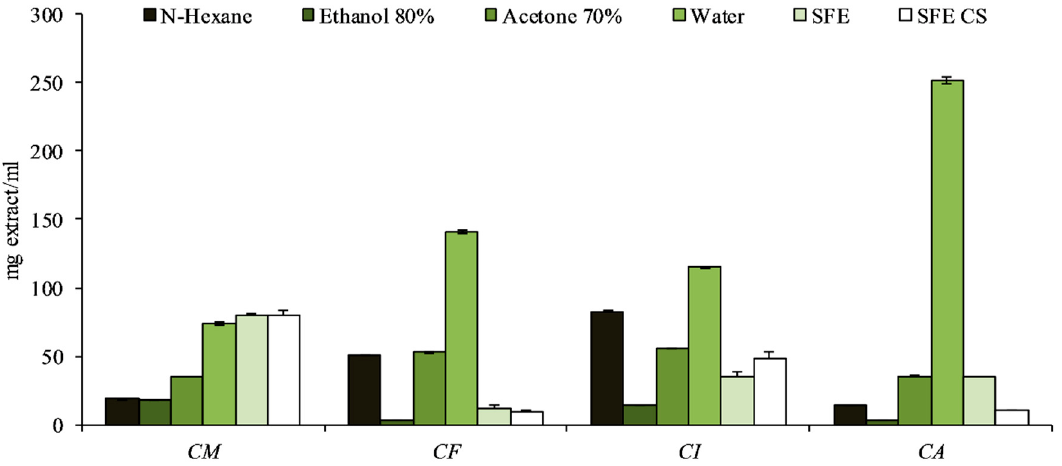
Figure 4. Reducing power (EC 50 , mg/mL) determined in extracts obtained from dried leaves of different Calendula species ( CM: C. maritima ; CF: C. fulgida ; CI: C. hybrid ( maritima × fulgida ); CA: C. arvensis ), with different solvents (Results of the statistical analysis are shown in Supplementary Table S4).